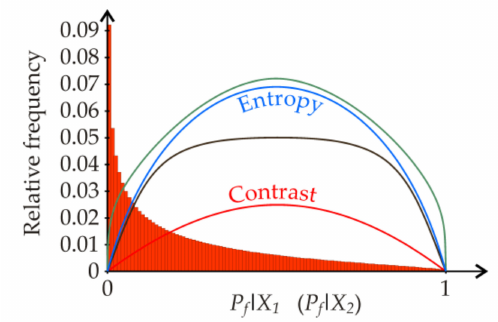
Figure 3. The sensitivity measure M ( P f ).